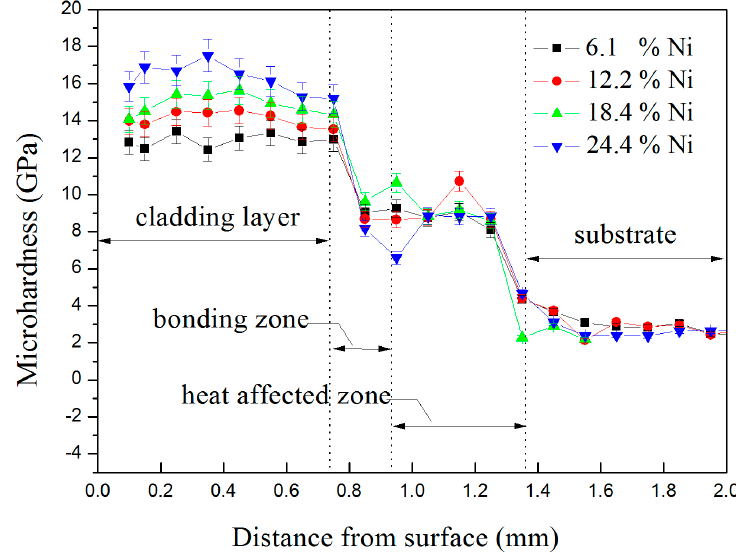
Figure 4. Cross ‐ section hardness curves of the Co ‐ base alloy coatings with different Ni contents. Figure 4. Cross-section hardness curves of the Co-base alloy coatings with different Ni